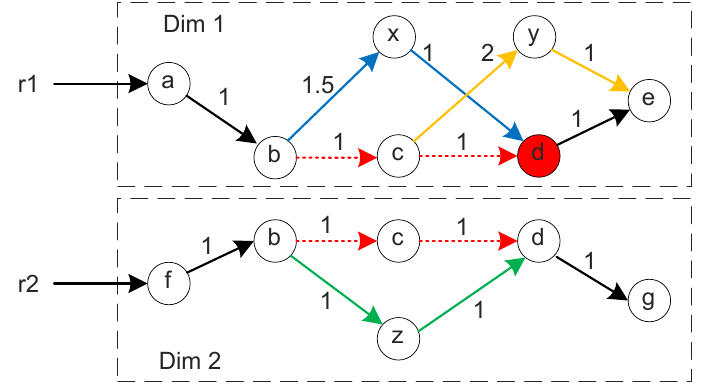
Figure 8. Illustration of the difference in planning among soft-collision A* (SC-A*), soft-collision M* (SC-M*), and soft-collision conflict-based search